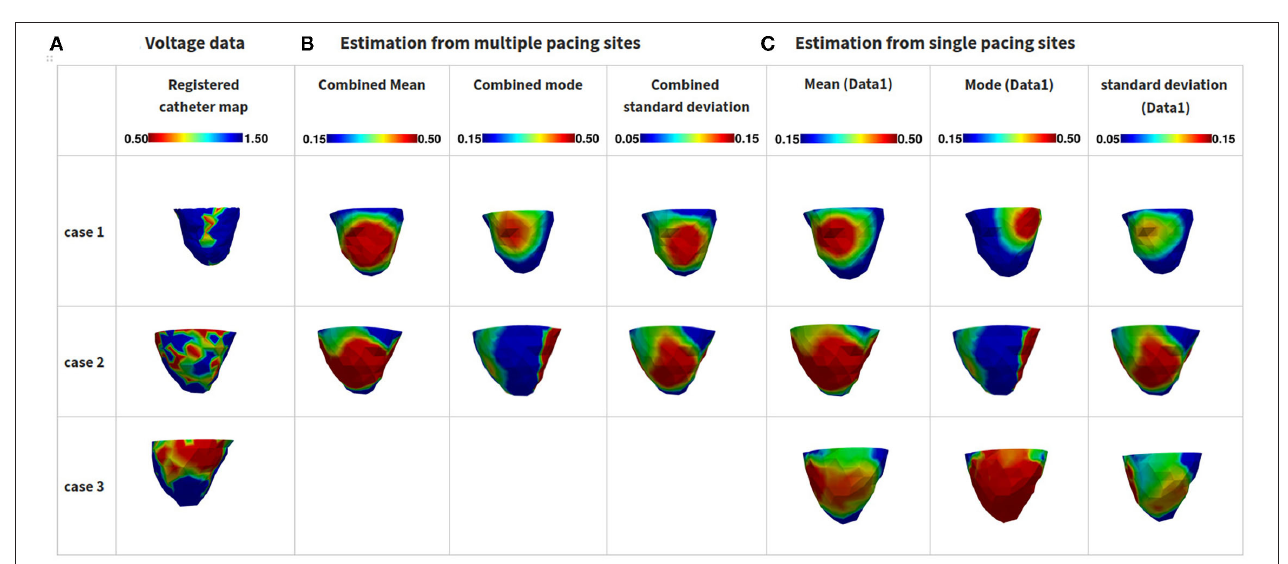
FIGURE 8 | Results of estimated tissue excitability from the presented method in real clinical data. (A) Voltage data from catheter map. (B) Mean, mode, and standard deviation estimated from multiple observations from different pacing sites. (C) Mean, mode, and standard deviation estimated from a single observation from one pacing